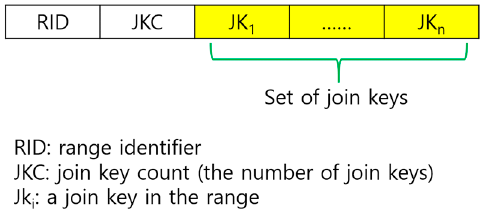
Figure 6. Range descriptor.